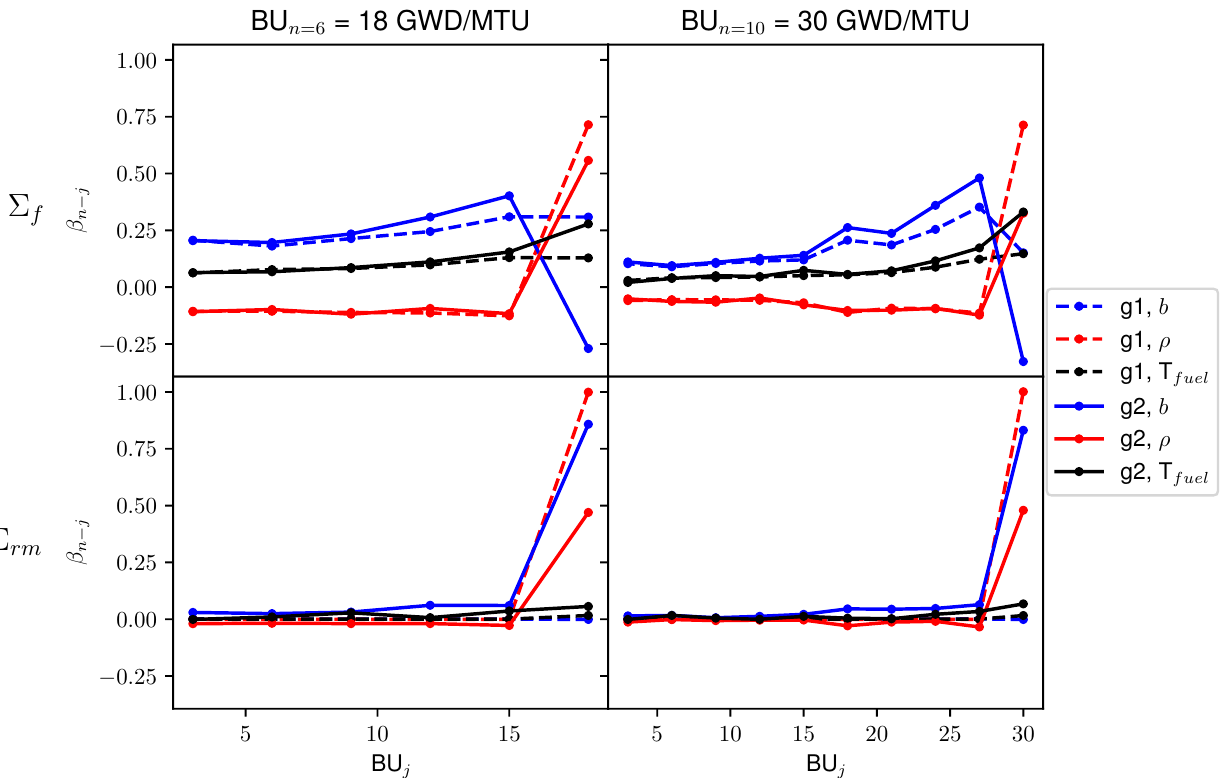
Figure 5. Sensitivity coefficients for previous and current values of state vector ⃗ x for a burnups equal to 18 GWD/MTU and 30 GWD/MTU using the CHM. In the legend, g# indicates the energy group of the HXS for which the sensitivity measure